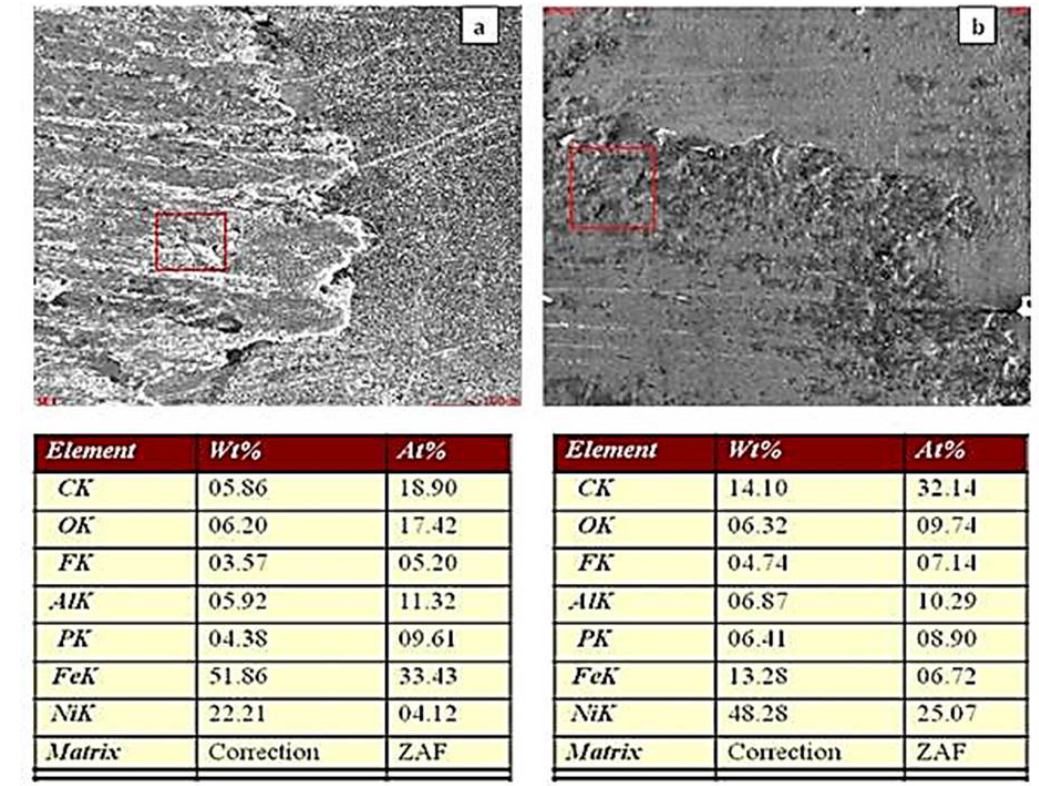
Figure 5. SEM/EDAX of worn surface of NiPPA nano-dispersion coating at 30N load (a) as plated and (b) after 400 ◦ C temperature.